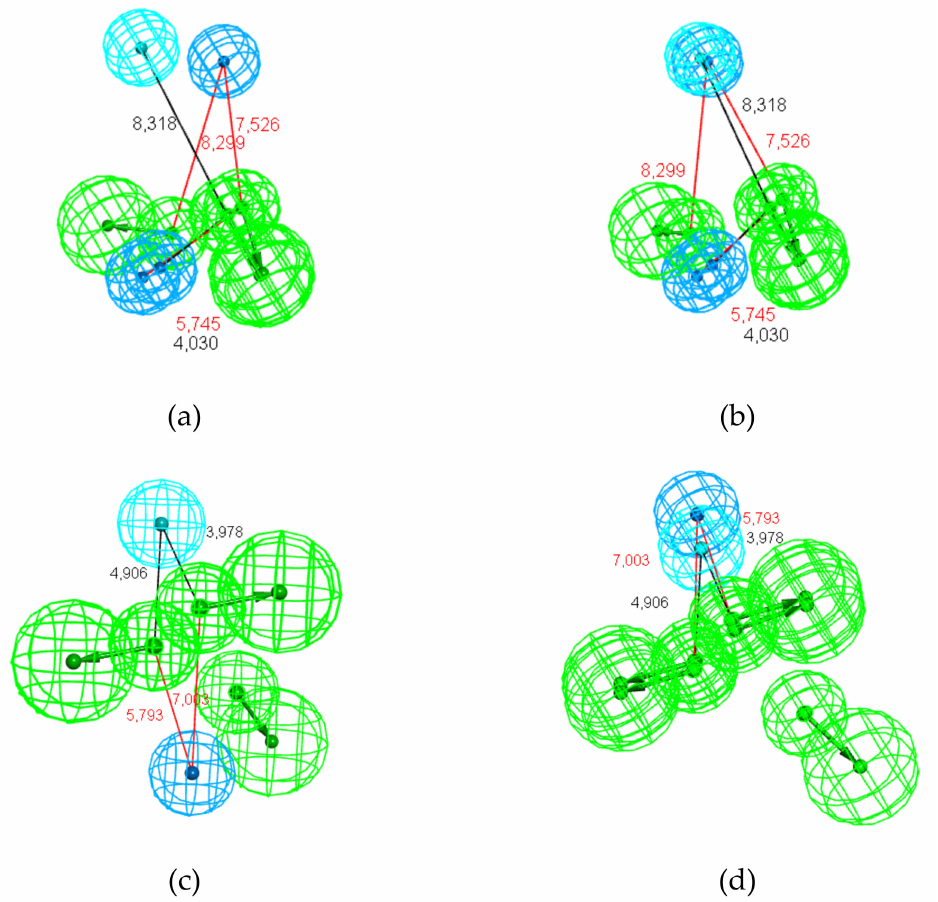
Figure 11. Pharmacophore mappings of the distant hypotheses improved by tethering related hydrophobic features (Hy and Hy-al): ( a ) Hypo1_t-STR and Hypo1_t-PNA (the distances between the Hypo1_t-STR features are shown in black, and the distances between the Hypo1_t-PNA features are shown in red); ( b ) Hypo1_t-STR and Hypo1_t PNA after tethering the hydrophobic features; ( c ) Hypo1_t-CAR and Hypo1_EXP (the distances between the Hypo1 t-CAR features are shown in black, and distances between the Hypo1_EXP features are shown in red); and ( d ) Hypo1_t-CAR and Hypo1_EXP after tethering the hydrophobic